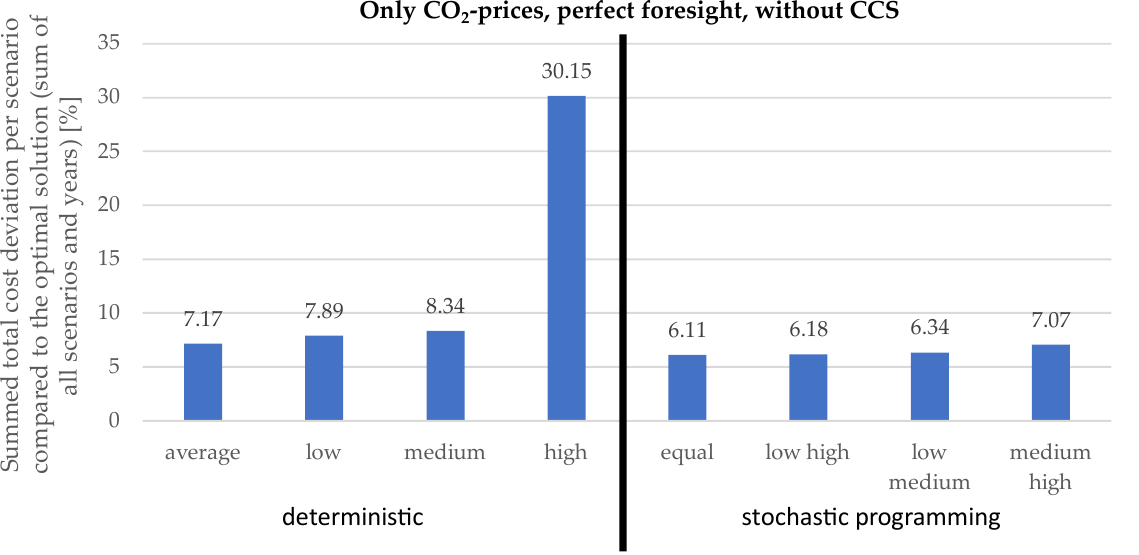
2 prices (perfect foresight, without